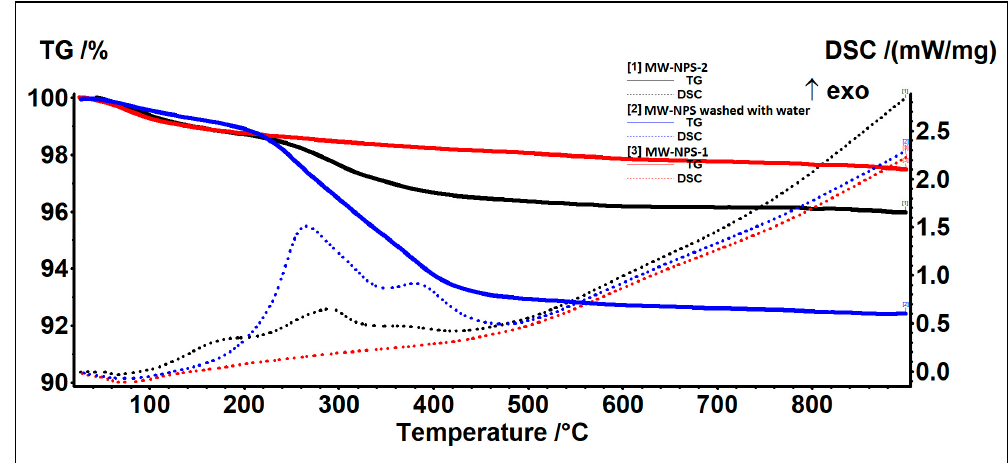
Figure 4. The TGA analysis of MW-NPS after the water washing, MW-NPS-1 and MW-NPS-2 .